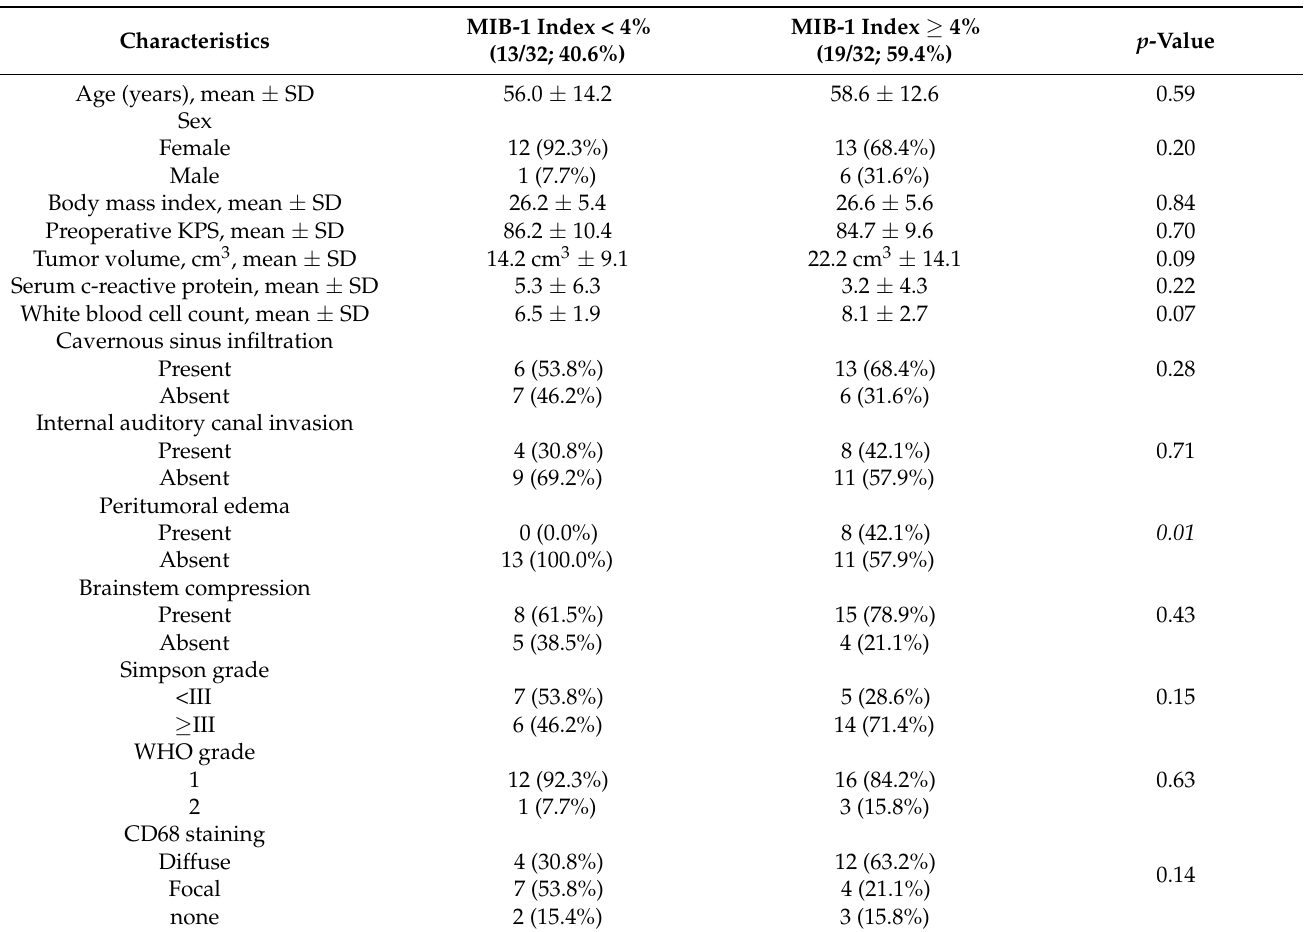
Table 2. Baseline clinical, laboratory, and imaging characteristics in petroclival meningioma patients with an increased and normal MIB-1 index (using Fisher’s exact test (two-sided) and independent t